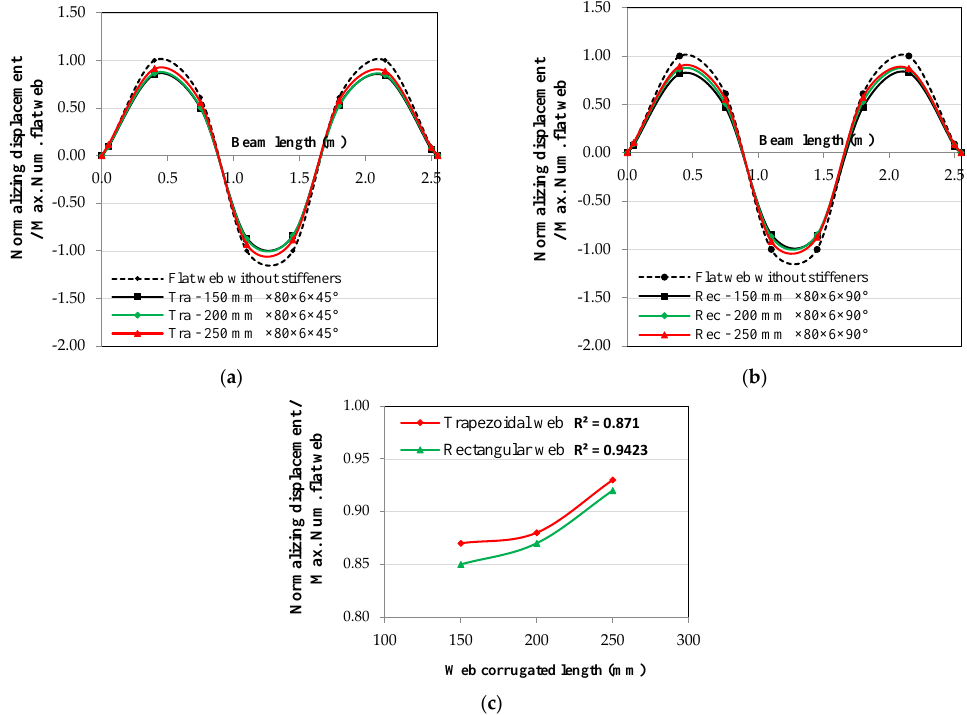
Figure 17. Corrugated length effect on the relationship between normalized displacement and beam length for the 3rd mode shape: ( a ) trapezoidal web, ( b ) rectangular web, and ( c ) length effect at the 3rd mode shape.